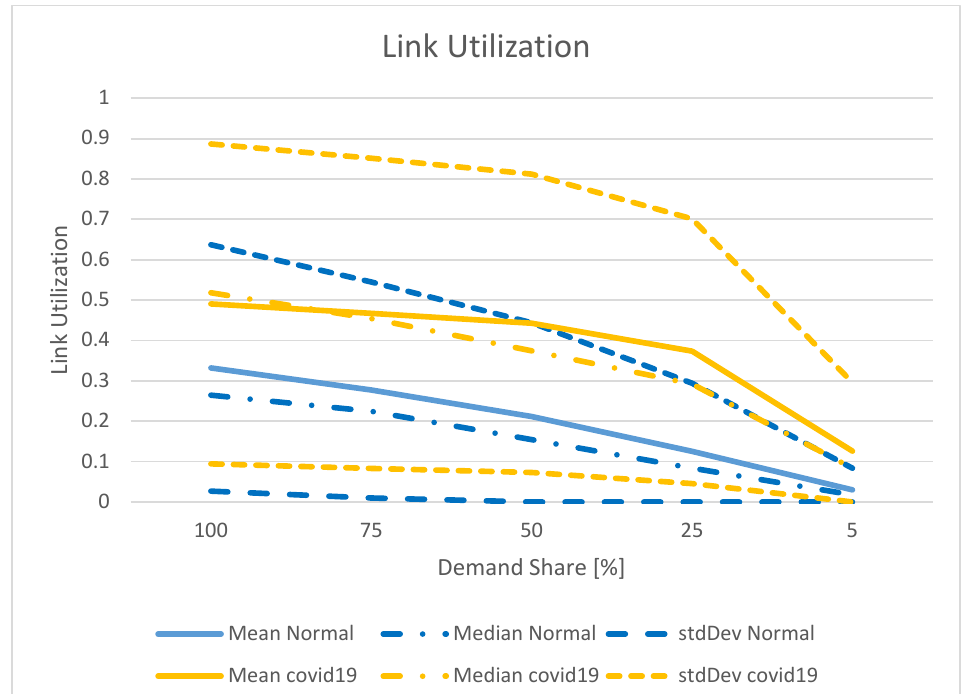
Figure 4: Link Utilization normal and covid19 case statistical indicators